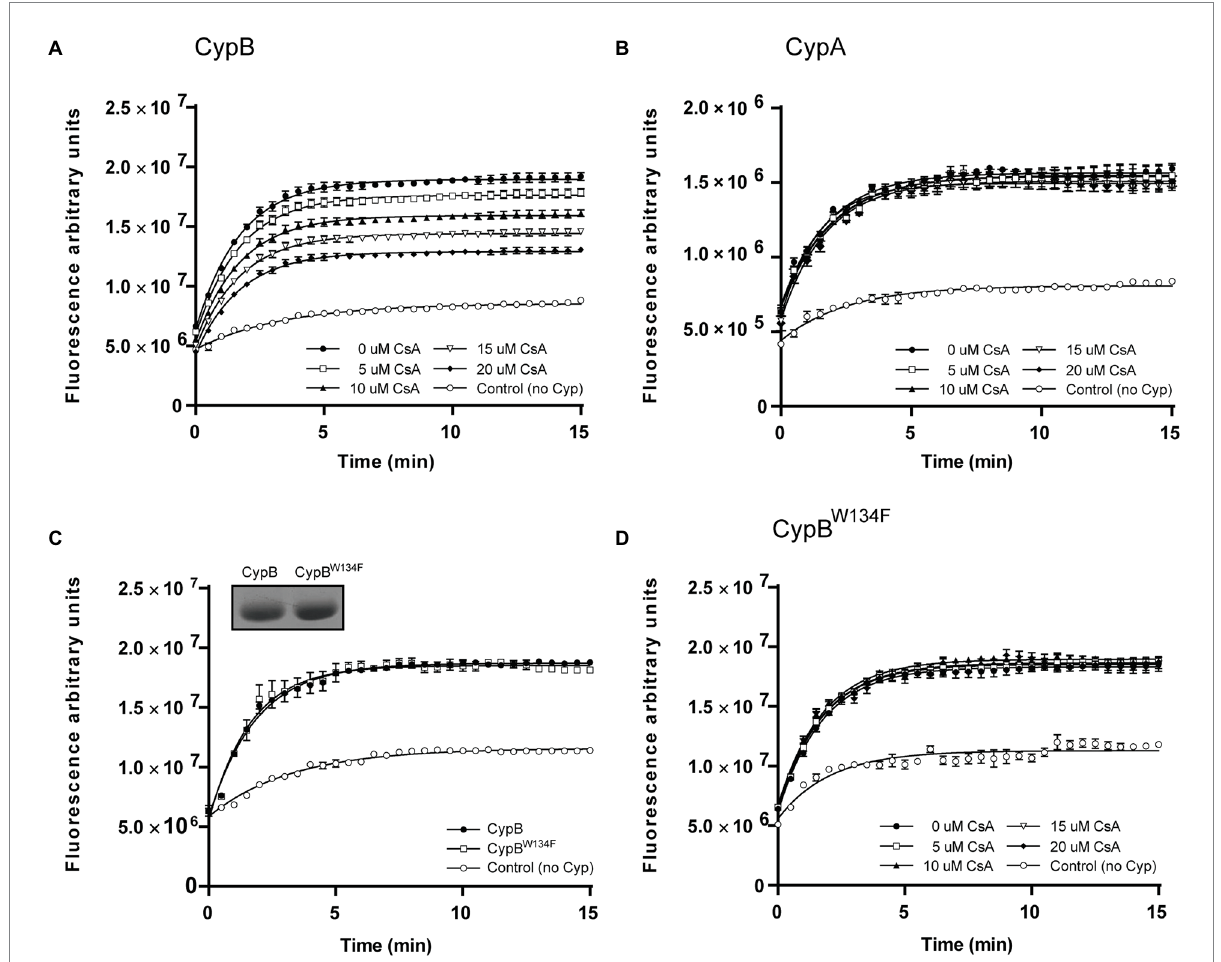
FIGURE 4 Inhibition of enzyme activity by cyclosporin A. CypB (A) , CypA (B) , or CypB W134F (D) were preincubated with increasing concentrations of CsA and the remaining PPIase activity was analyzed with the GFP PPIase activity assay. (C) GFP PPIase activity assay with 2 μ M of CypB W134F . In inset Coomassie blue of purified CypB W134F . The figures show the mean and standard deviation of triplicate experiments and are representative of three independent experiments. Two-way ANOVA and Tukey’s multiple comparison test (within each row, compare columns) were used to analyze the statistical significance of the results, **** p <